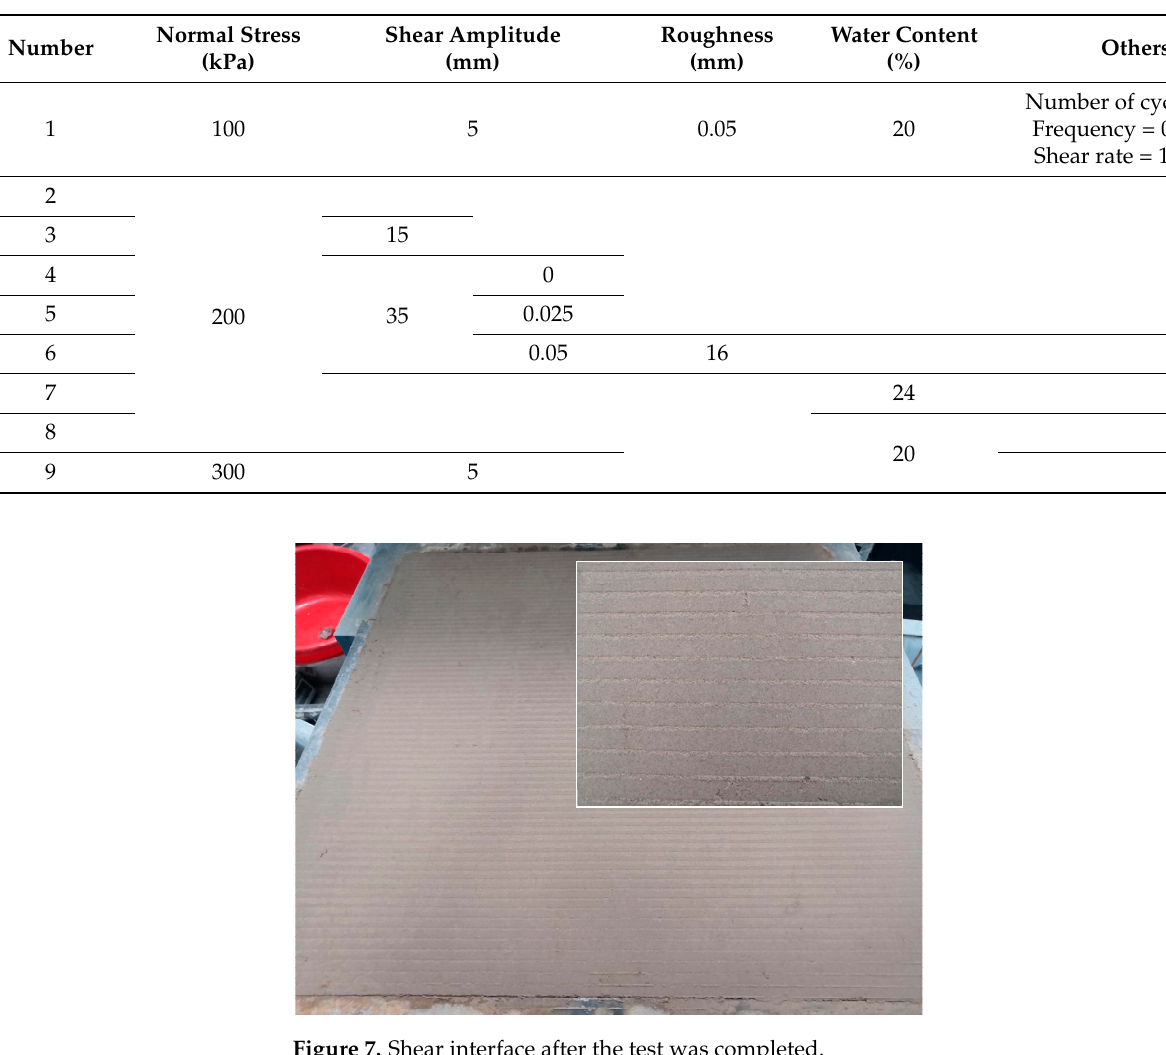
Table 1. Testing scheme.